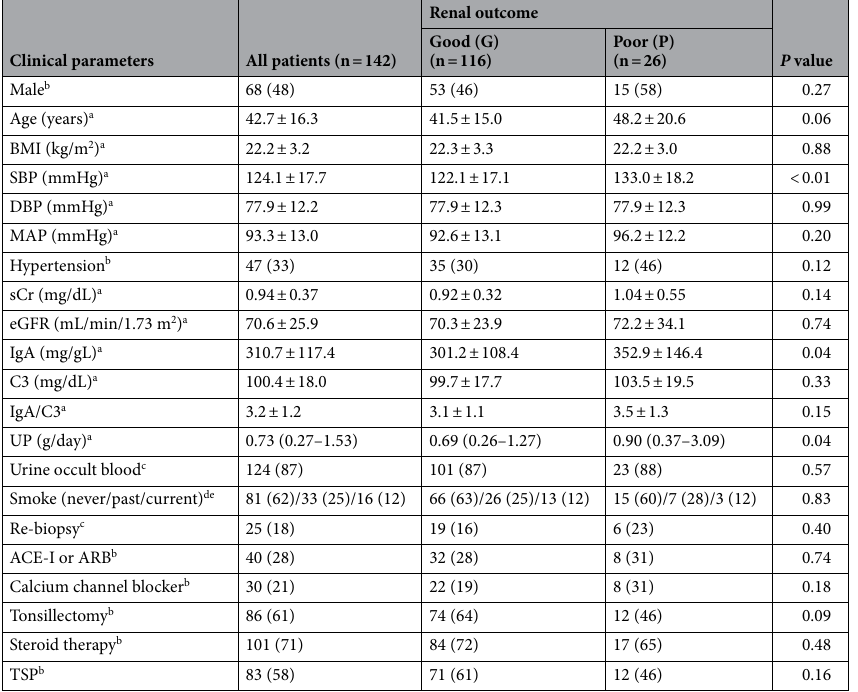
Table 1. Clinical characteristics at baseline. Data are mean ± standard deviation, n (%), or median (inter- quartile range) unless otherwise indicated. BMI, body mass index; SBP, systolic blood pressure; DBP, diastolic blood pressure; MAP, mean arterial pressure; sCr, serum creatinine; eGFR, estimated glomerular filtration rate; UP, urinary protein; ACE-I, angiotensin converting enzyme inhibitor; ARB, angiotensin receptor blocker; TSP, tonsillectomy combined with steroid pulse therapy. a Student’s t -test. b Pearson’s chi-square test. c Fisher’s exact test. d Wilcoxon test. e n =